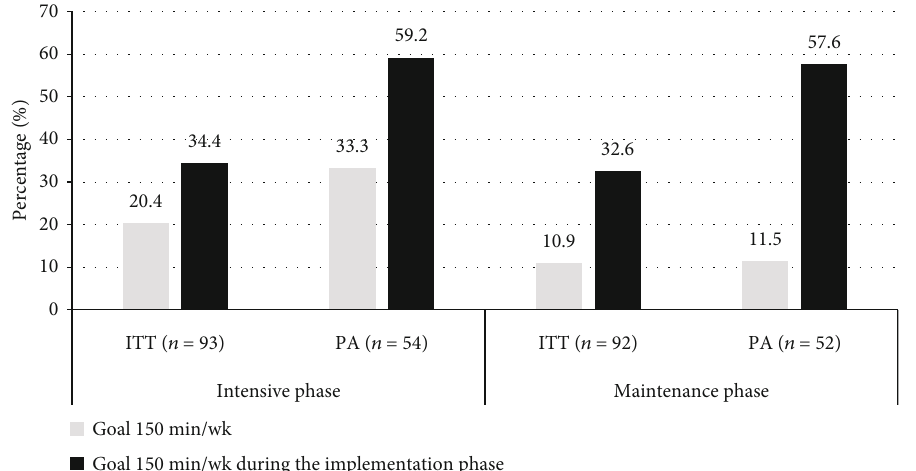
Figure 3: Goal of physical activity achieved by the participants in the intensive and maintenance phase of the program. ITT: intention to treat analysis; PA: protocol analysis